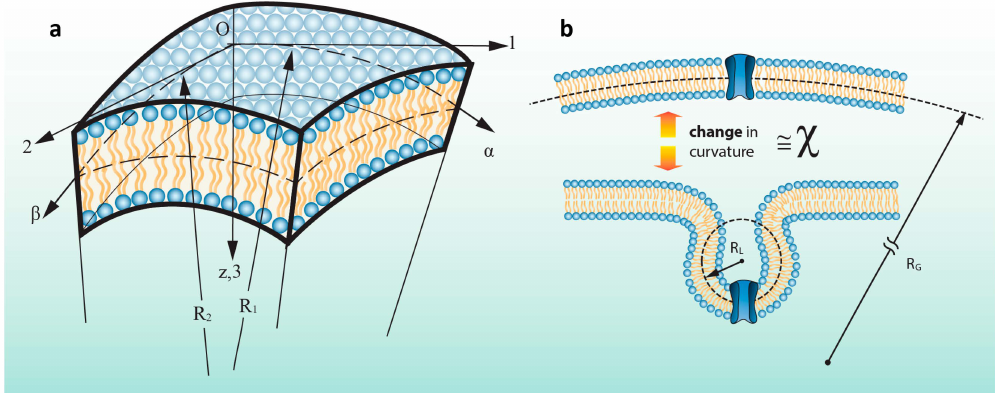
Figure 2. Schematic of membrane curvature. ( a ) An element of a membrane patch where the principal coordinates, Lamé parameters, radii of curvature, R1 and R2, change in curvature terms, χ 1 and χ 2 are shown. α and β are lines of curvature in the curvilinear coordinates; ( b ) Schematic description of the “change” in curvature term. This parameter, χ , is the change in curvature from the bilayer mid-plane between two different